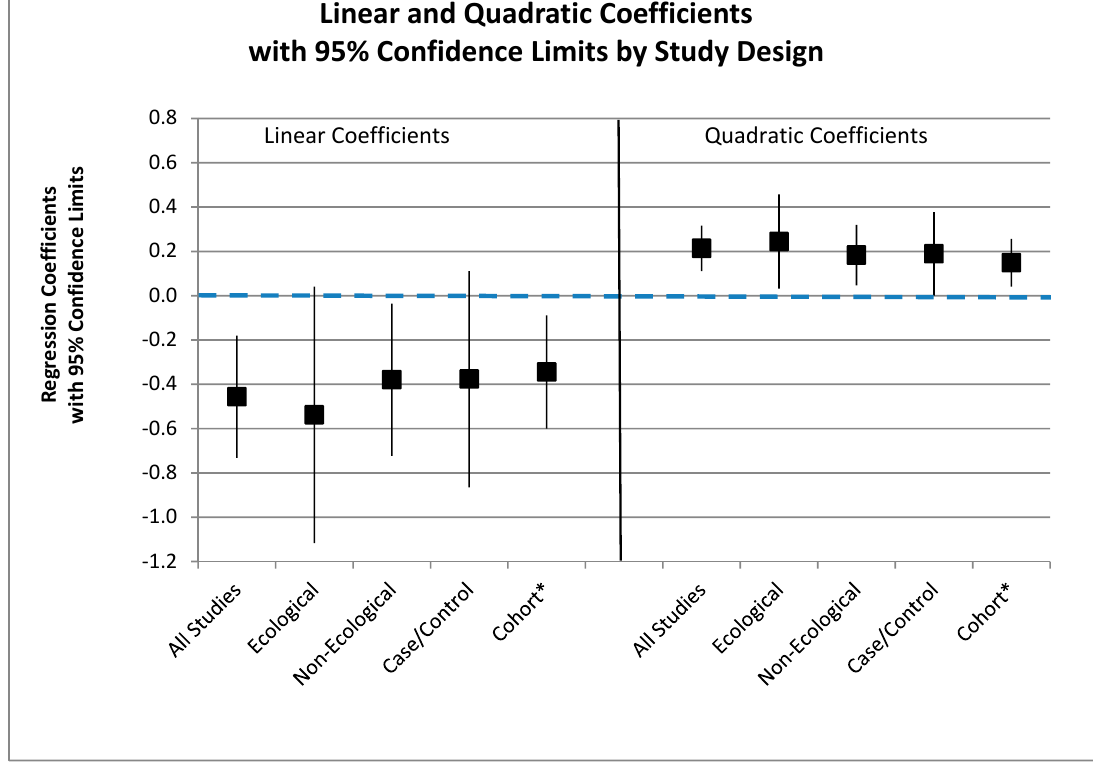
Figure 3. Linear and quadratic coefficients by study design. * Regression coefficients; others meta-regression.